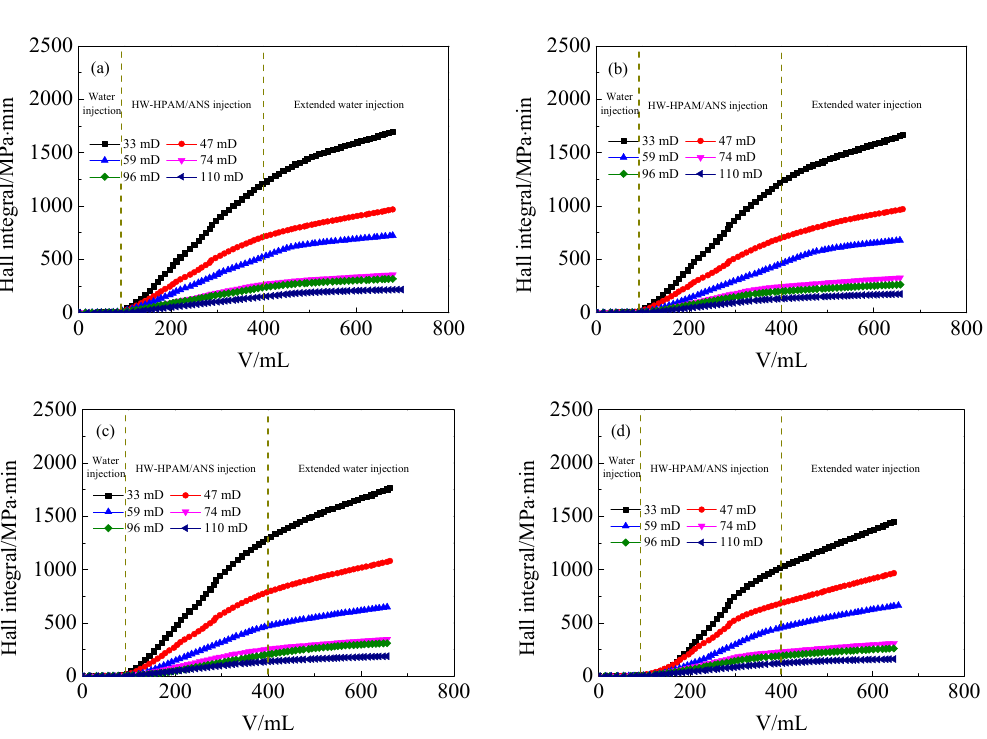
Figure 15. Hall curves of LW-HPAM/ANS at different concentrations of LW-HPAM under different permeability core conditions. V: Cumulative injection, c ANS =3.0 g ⋅ L − 1 . ( a ) 0.8 g ⋅ L − 1 , ( b ) 1.5 g ⋅ L − 1 , ( c ) 2.3 g ⋅ L − 1 and ( d ) 3.0 g ⋅ L − 1 .